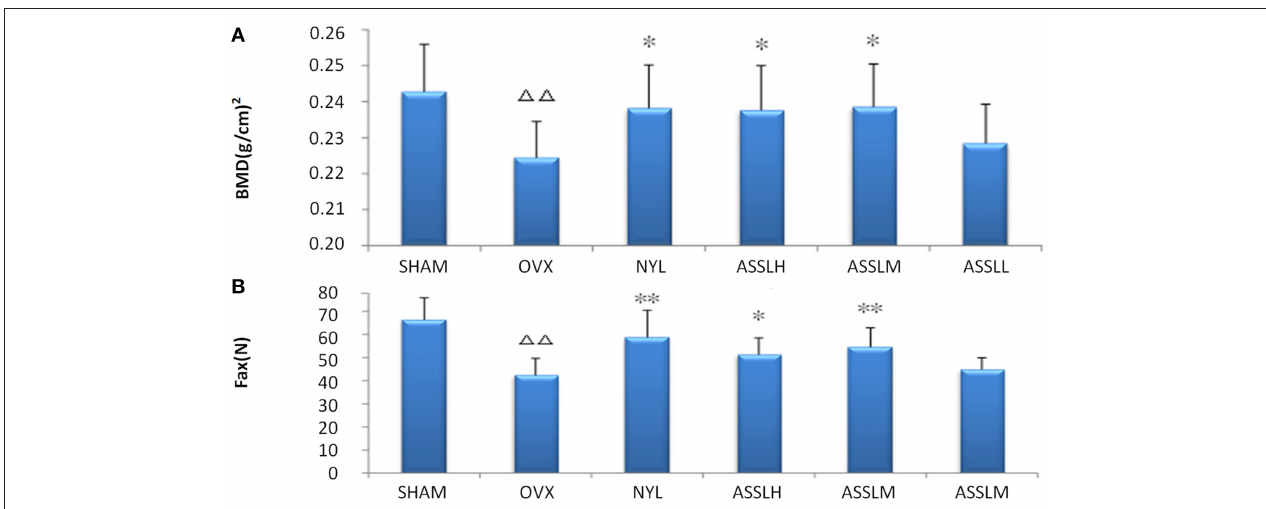
FIGURE 1 | Effects of nylestriol and total lignans on the bone mineral density and the maximum load of ovariectomized osteoporosis rat model (compared with sham group, 1 1 P < 0.01; the OVX model group, * P < 0.05, ** P < 0.01) (A) bone mineral density (B) maximum load. of the OVX group decreased compared with the SHAM group ( P < 0.01). Compared with the OVX group, NYL and